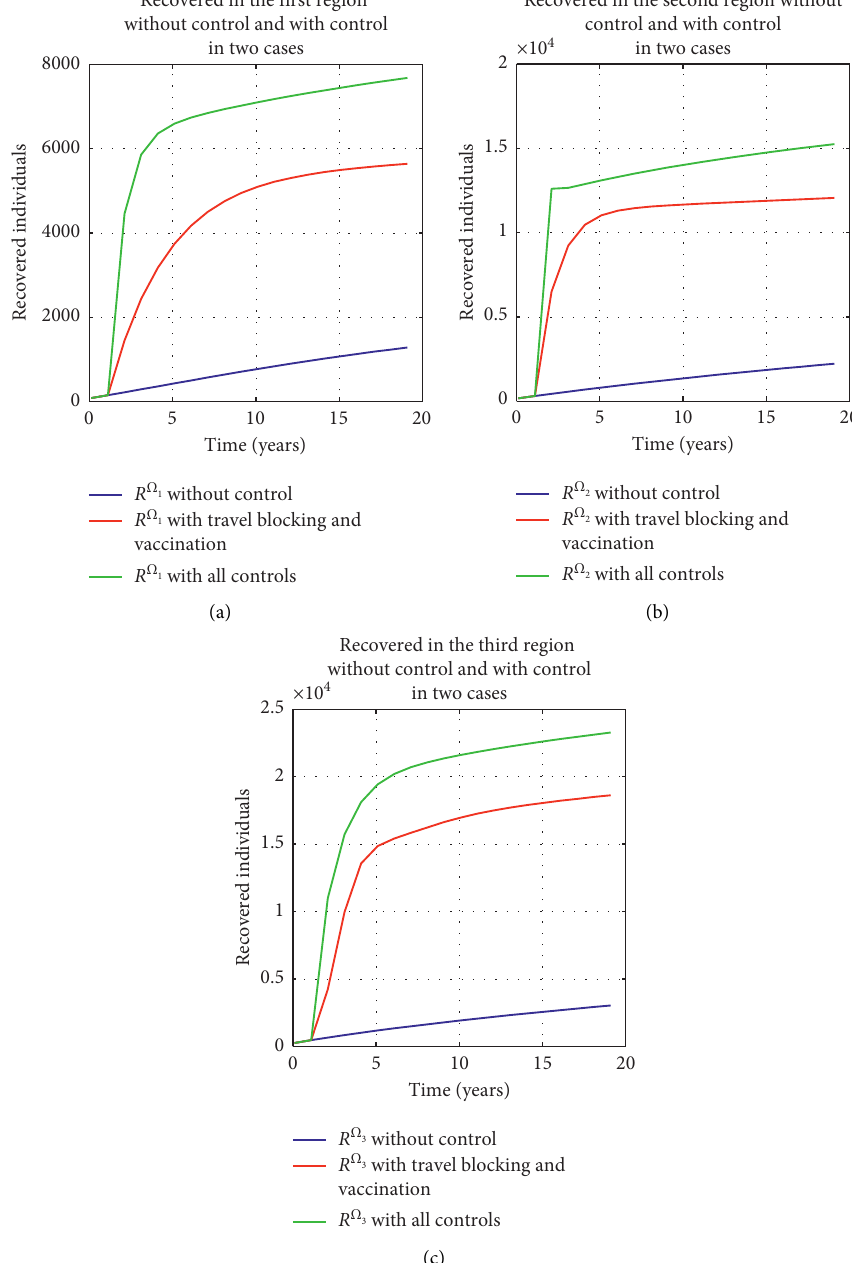
Figure 13: Comparison of the recovered in each region without control and with control in two